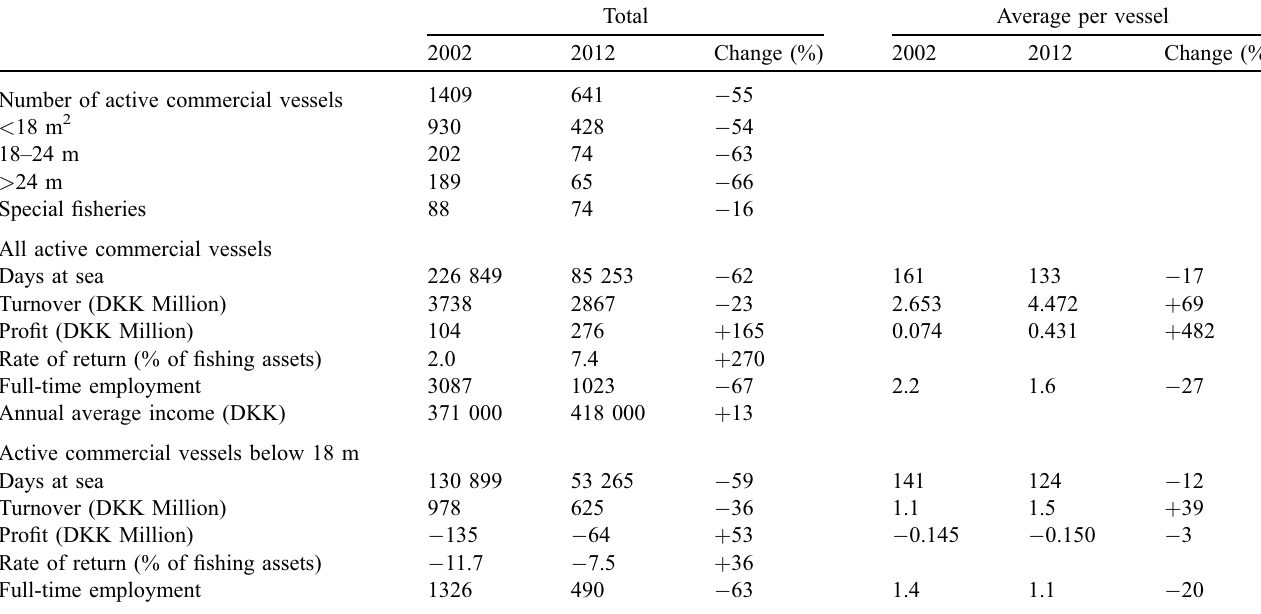
Table 1. Key numbers for the Danish fi shing fl eet, 2002 and 2012, nominal values 1 .